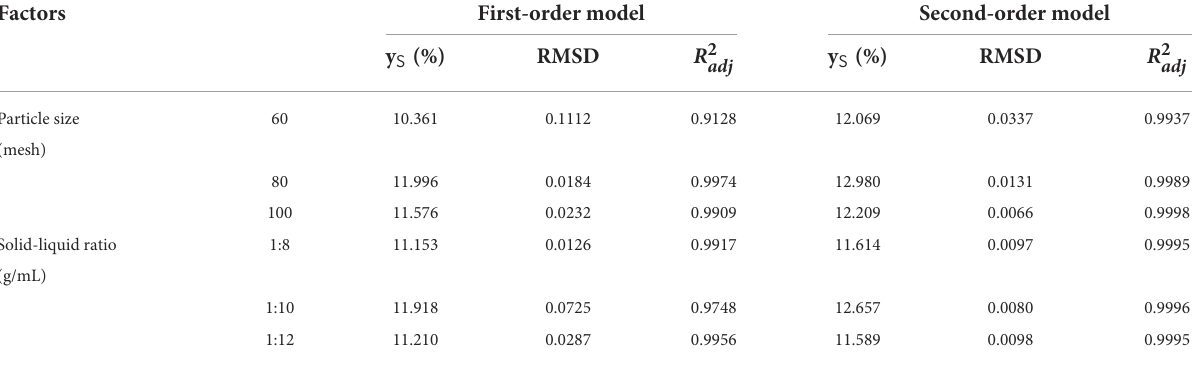
TABLE 2 RMSD and R 2 adj values for first-order kinetics and second-order kinetics under the extraction conditions studied. Factors First-order